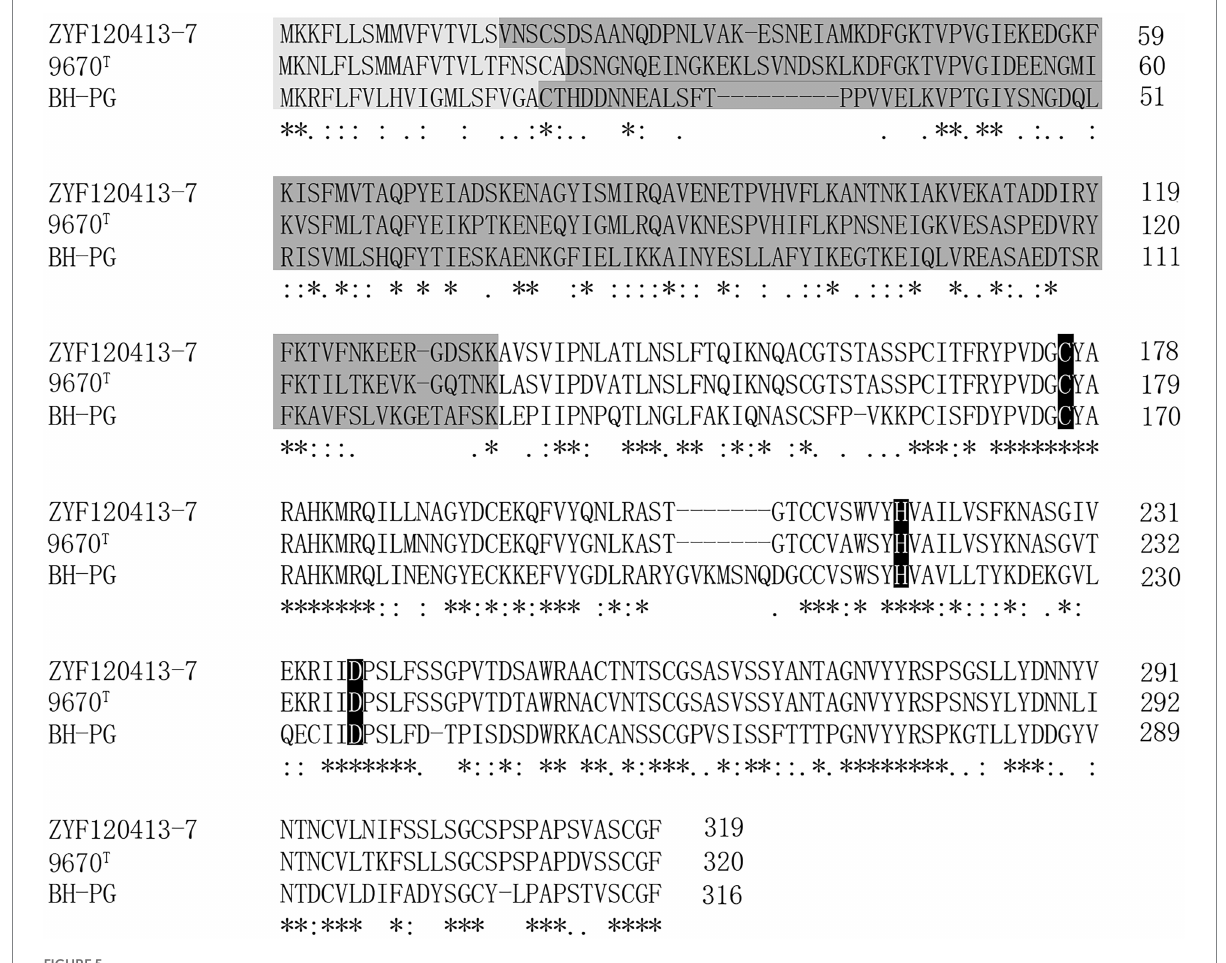
FIGURE 5 Alignment of the PG from Bacteroides helcogenes (BH-PG; UniProt ID: E6SWX4), Chryseobacterium proteolyticum (9670 T , UniProt ID: Q9AQQ8), and Chryseobacterium cucumeris ZYF120413-7 (ZYF120413-7; GenBank ID: ON408292). The symbols denoting the degree of conservation are as follows: (“*”) identical residues; (“:”) conserved substitutions; (“.”) semi-conserved substitutions. Light gray indicates the predicted signal peptide, dark gray indicates the predicted pro-region, and others indicate the mature sequences. Amino acids indicated in white on the black background are the predicted amino acids of the active